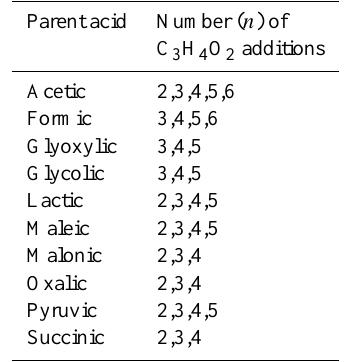
Table 2. Parent acid and C 3 H 4 O 2 oligomer series detected in all continental and coastal storms. Each addition of C 3 H 4 O 2 to the par- ent acid is denoted by corresponding number (n) and results in a loss of